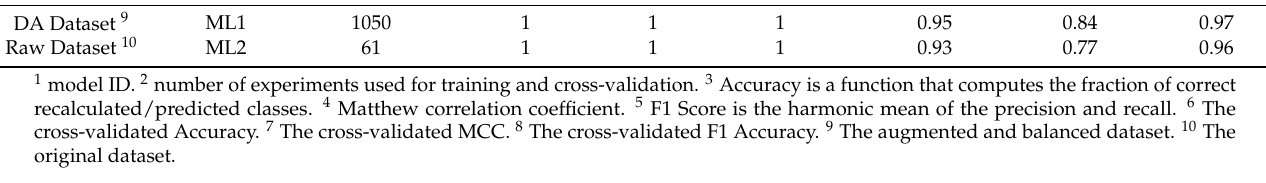
Figure 2. Top 3 levels of the RF second decision tree: most important chemical components from the DA dataset on M. canis bioactivities and EO-virtualized chemical composition. The full tree is re- ported as Supplementary Figure S2. Green path indicates posiTable 2. 5% and 0.2%, respectively) and α -citral at high percentages (more than 28.5%). Table 3. Classification model results for M. canis with data augmentation.